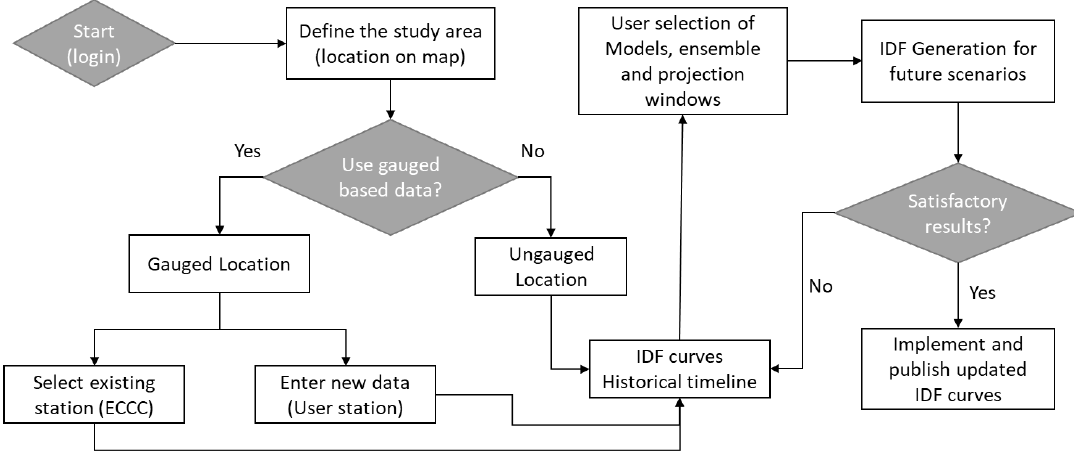
Figure 6. IDF_CC tool use flowchart.